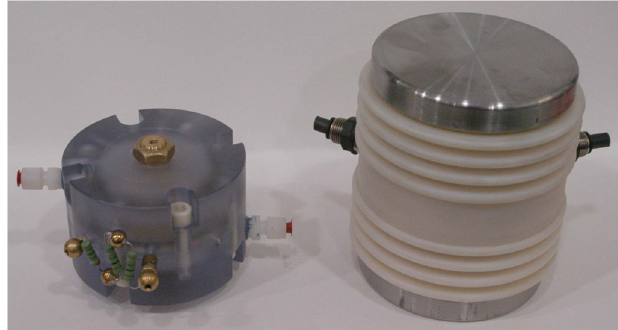
FIG. 2. Comparison of the 7.6-cm-tall L3-Sandia switch (left) used in the LTD-III experiments with the 15-cm-tall baseline switch (right) developed by the High Current Electronics Institute in Tomsk, Russia.